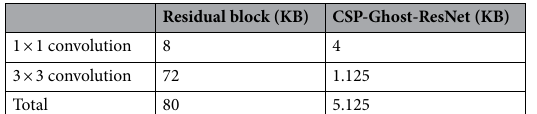
Table 2. Parameter size of the first stacking module of the Residual block and CSP-Ghost-ResNet.